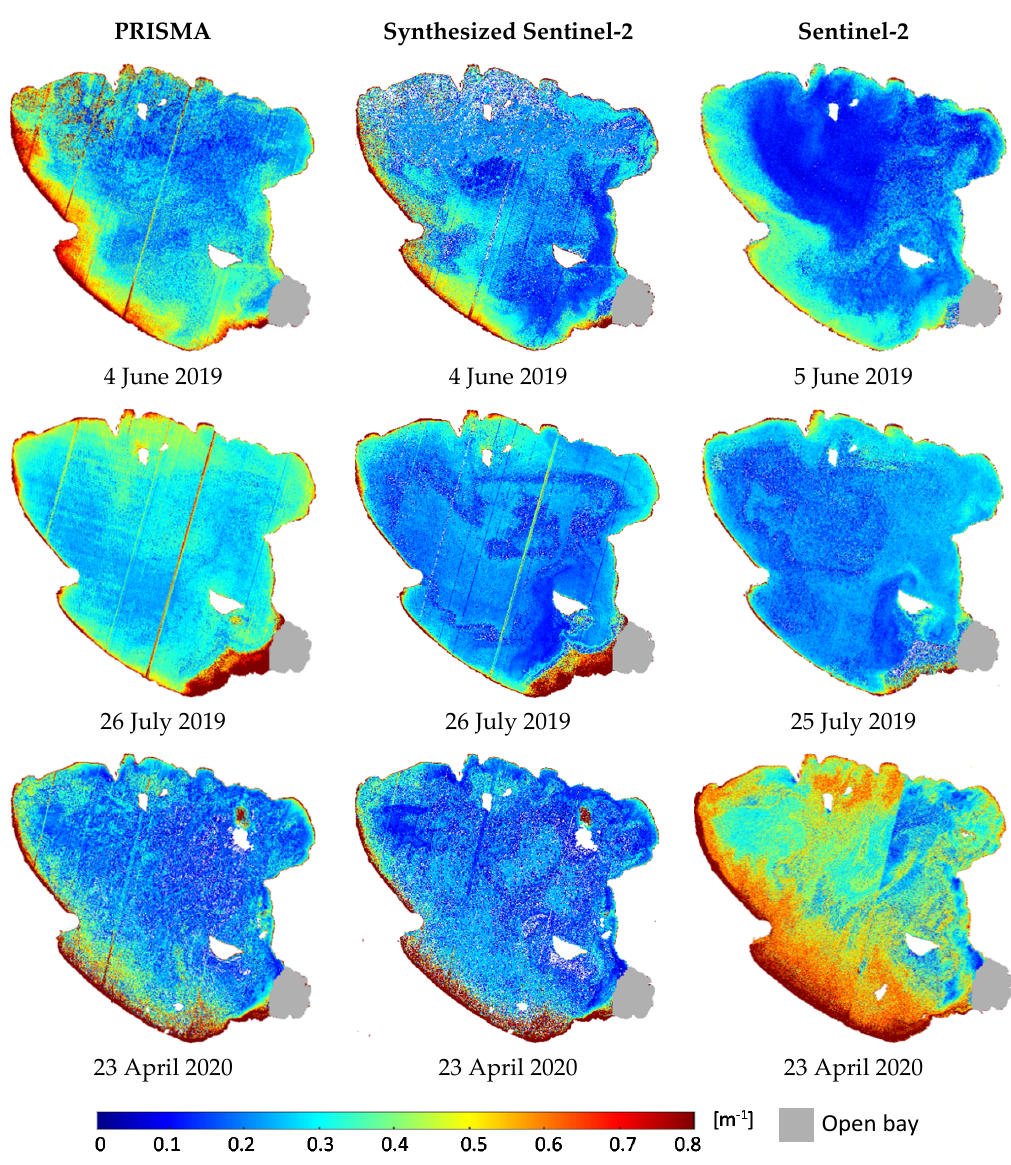
Figure 8. Multitemporal CDOM maps derived from PRISMA, synthesized Sentinel-2 (PRISMA resampled), and Sentinel-2 images.